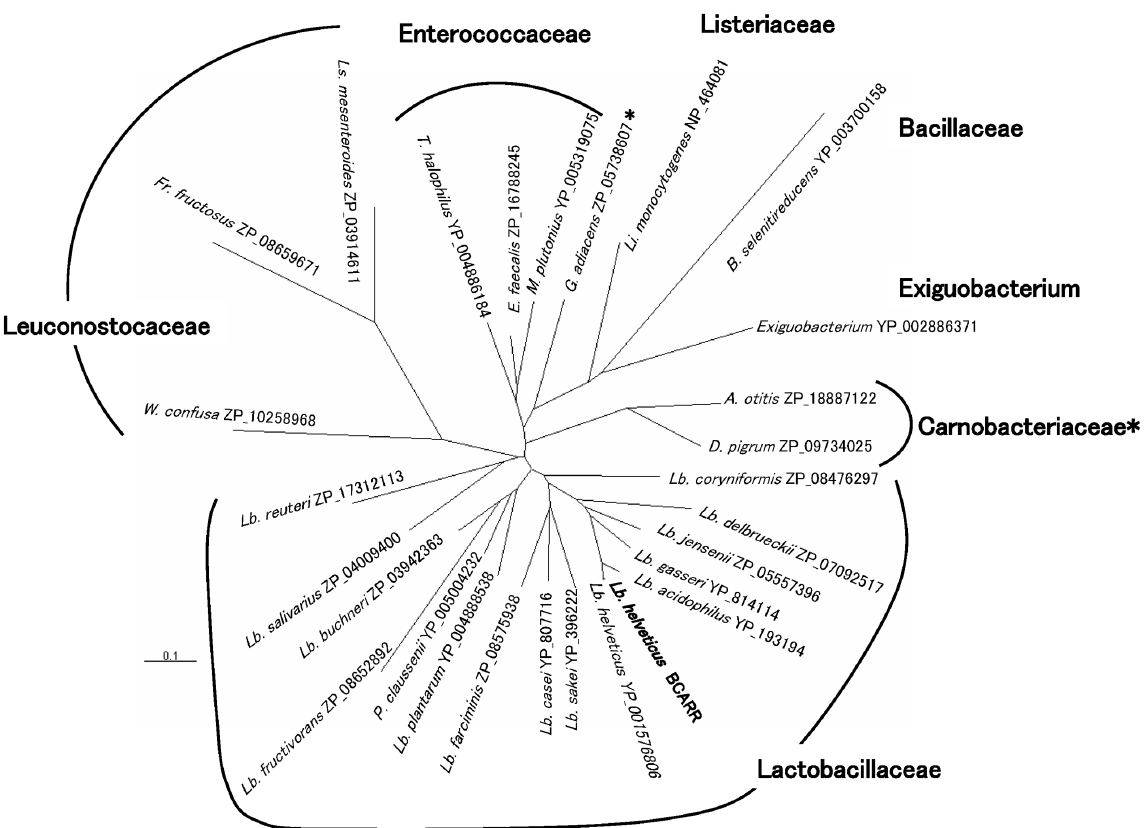
Figure 8. The phylogenetic tree of the BCARR. Homologous protein sequences were identified by BLASTP searches (cutoff e-value . 10 2 50 ). An unrooted phylogenetic tree displaying branch lengths that was built using ClustalW and the NJ algorithm is shown. To simplify the tree, one sequence was selected from each genus. For the genus Lactobacillus , four sequences were selected from the delbruekii subgroup including L. helveticus , one sequence from each subgroup other than the delbruekii subgroup as defined in the previous report [25]. The scale bar represents base changes per site. A. : Alloiococcus, B. : Bacillus, D. : Dolosigranulum, E. : Enterococcus, F. : Fructobacillus, G. : Granulicatella, Ls. : Leuconostoc, Li. : Listeria, M. : Melissococcus, P. : Pediococcus, T. : Tetragenococcus, W. : Weissella. * Carnobacteriaceae also includes G. adiacens .